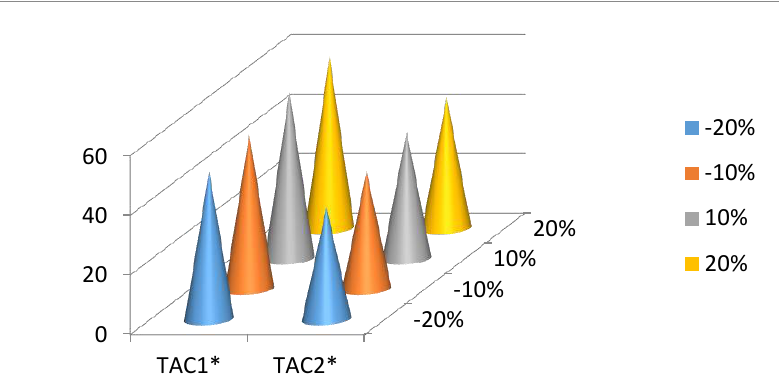
Fig. 5. Minimizing cost of both items for different values of 𝛄 𝟏 , 𝛄 𝟐